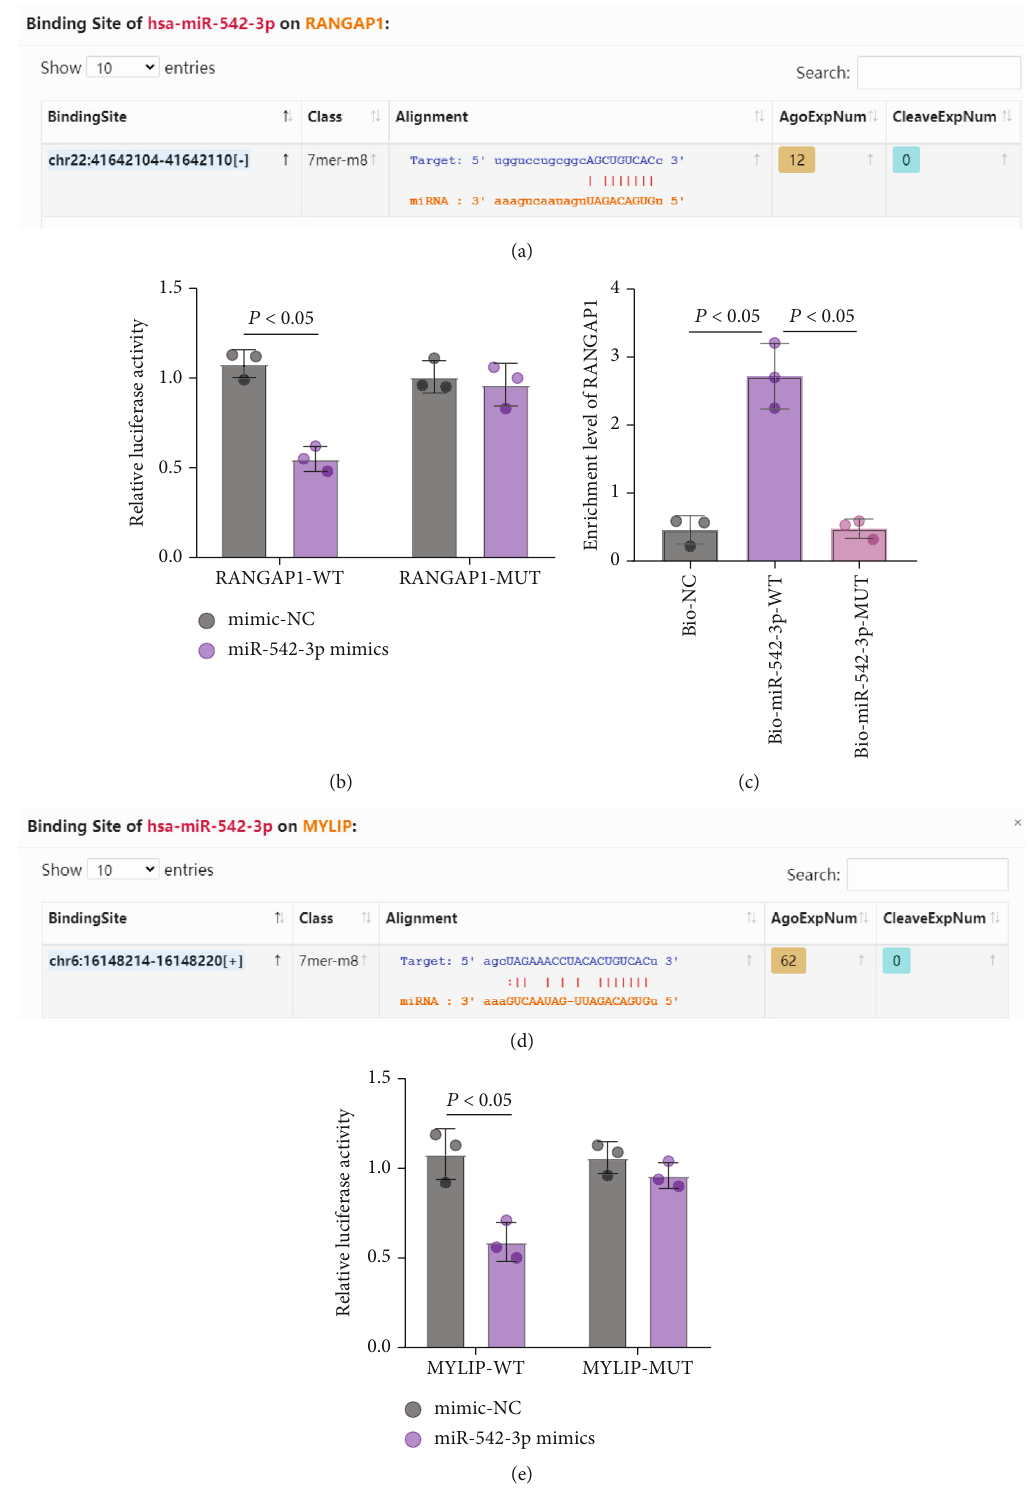
Figure 6: circ-RANGAP1 targets MYLIP via miR-542-3p. (a) Prediction of the binding sites of circ-RANGAP1 and miR-542-3p was